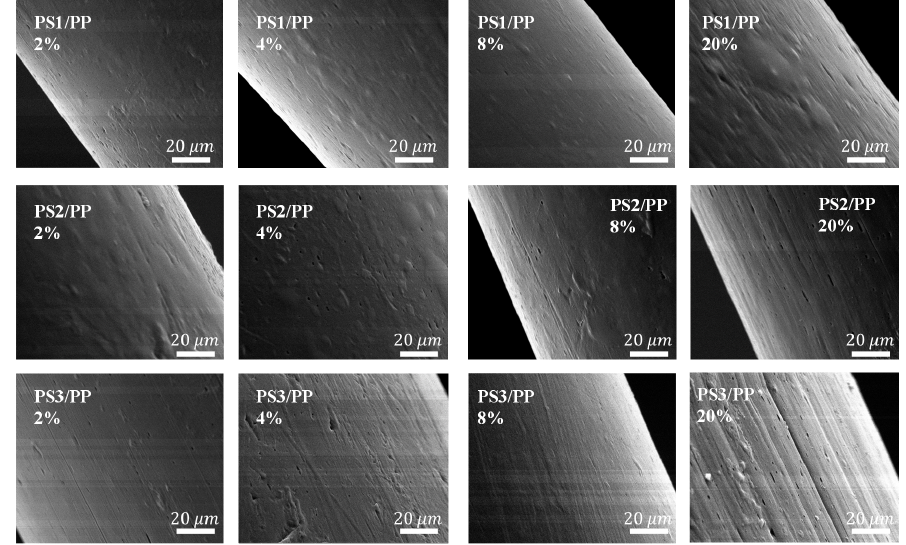
Figure 4. Surface micrographs of PS/PP fibers produced with different viscosity ratios and blend ratios after dissolving the surface PS domains.